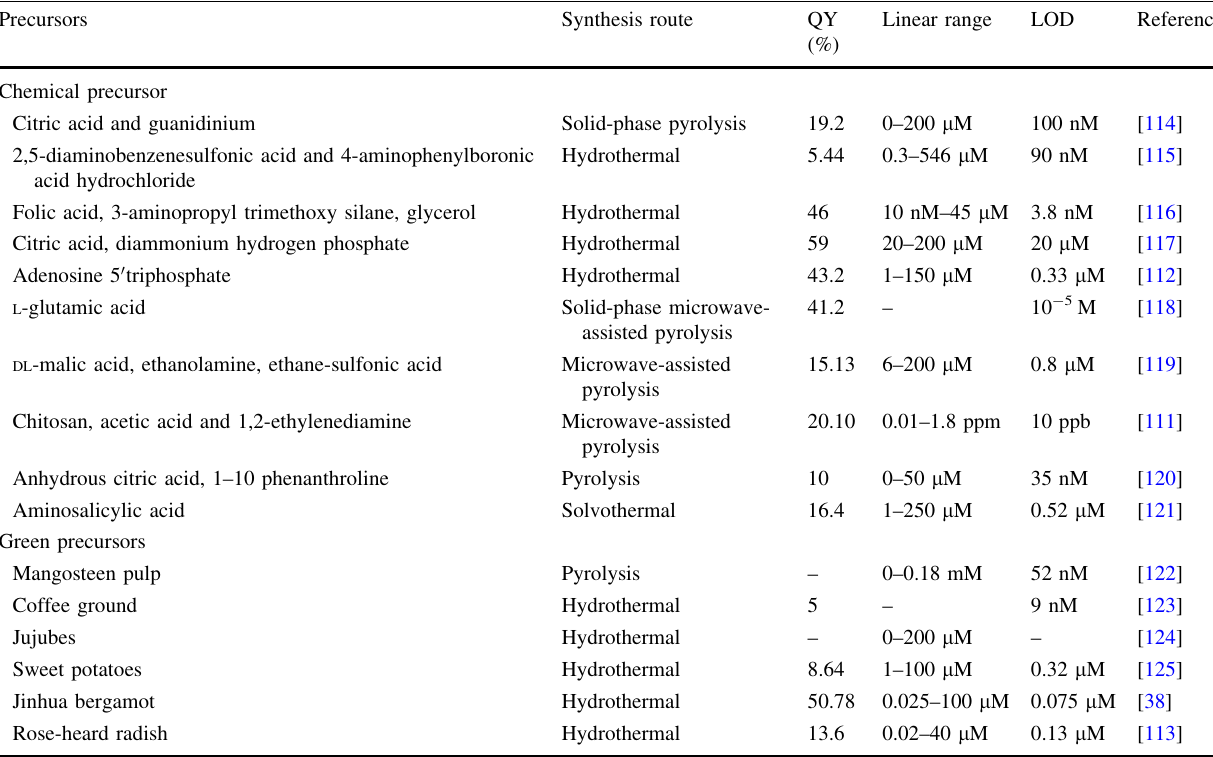
Table 2 Recent advances in the preparation of CDs, their corresponding properties, and Fe 3 ? ion sensing